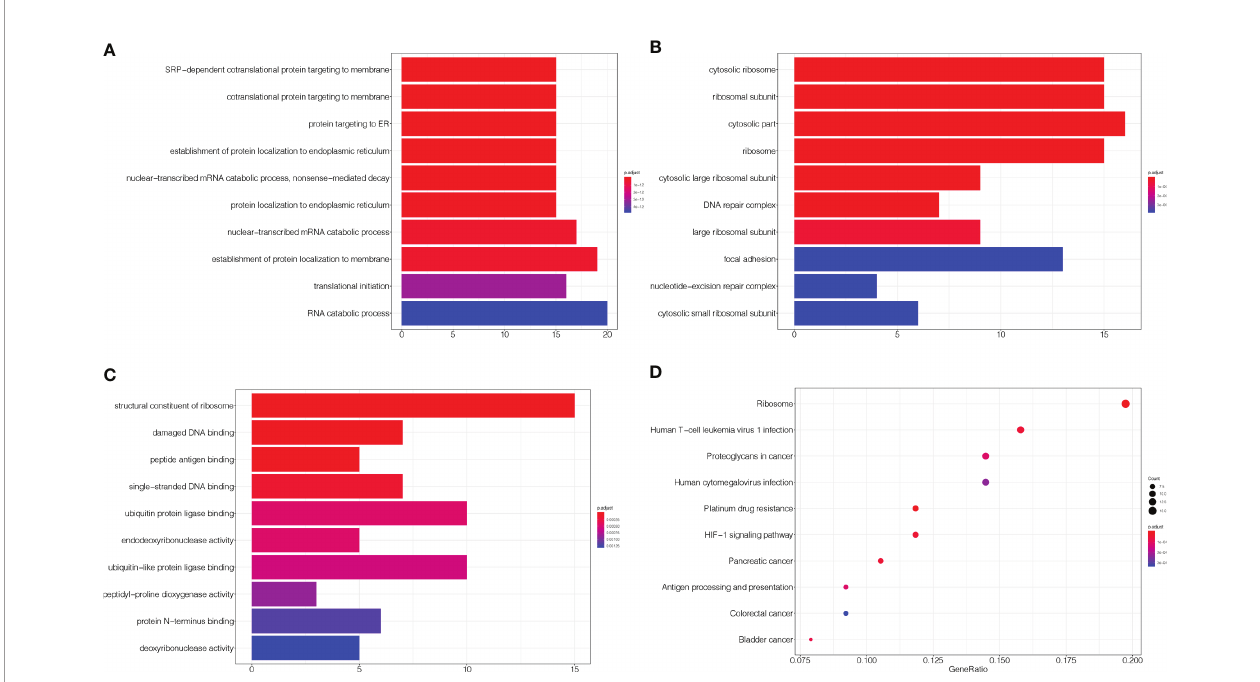
FIGURE 1 | GO and KEGG enrichment of related genes. (A – C) The top 10 GO terms in biological process, cellular component, and molecular function, respectively. (D) KEGG pathways were analysed, and the top 10 pathways are shown. The x -axis shows the GeneRatio, whereby a higher value indicates more genes enriched in the pathway; the y -axis shows the enriched pathways, and the redder the dot is, the more signi fi cant is the